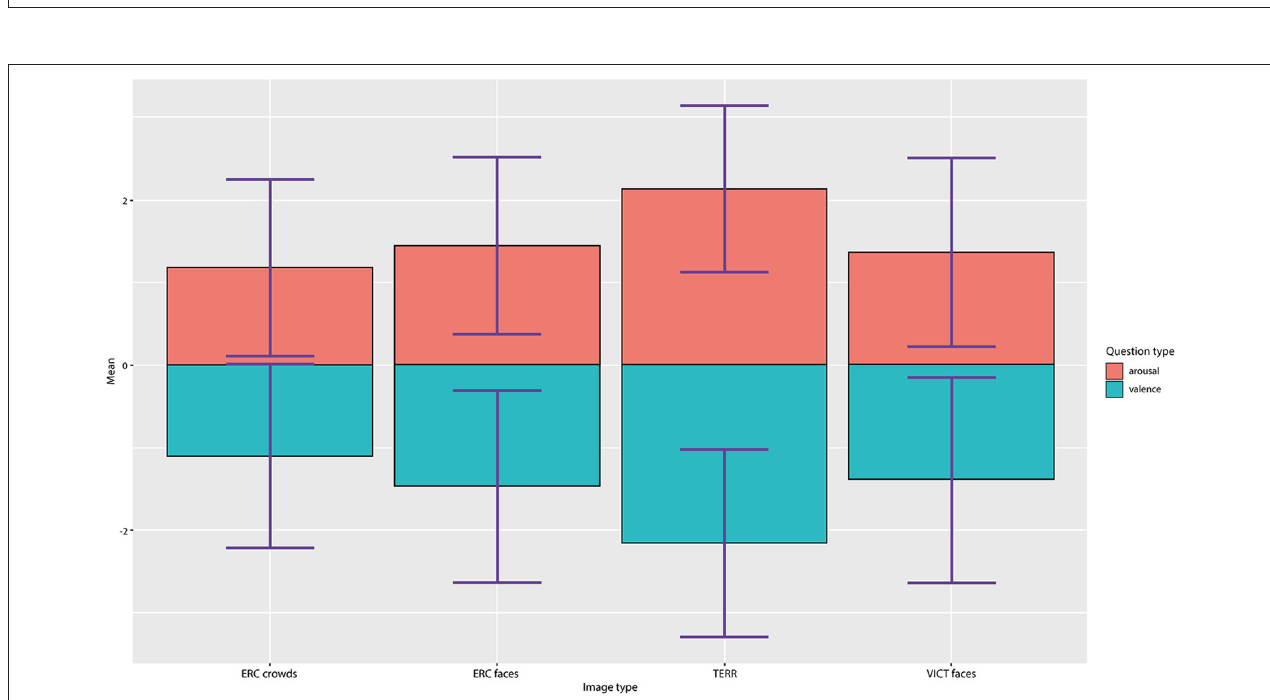
FIGURE 3 | Valence and arousal ratings. Results of the ratings of valence and arousal by a 7-point Likert scale (ranging from − 3 to + 3) evaluated for all four categories of photographs.